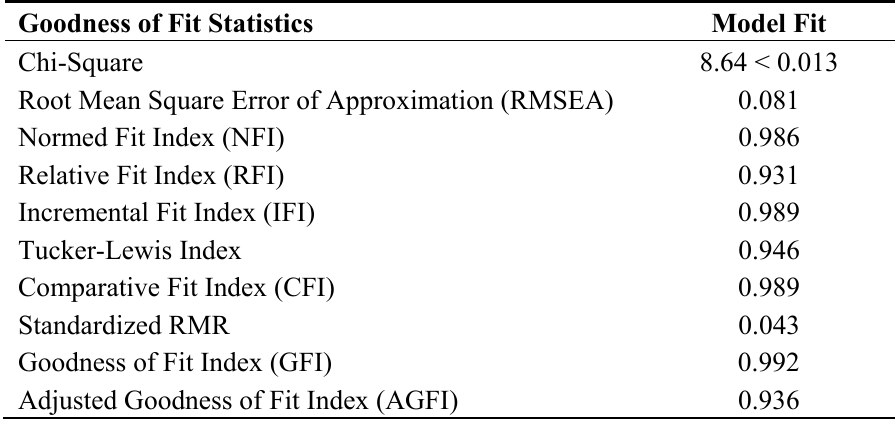
Table 4. Results of structural equation modeling testing the role of perceived commitment as a mediator in the relationship between organizational stressors and